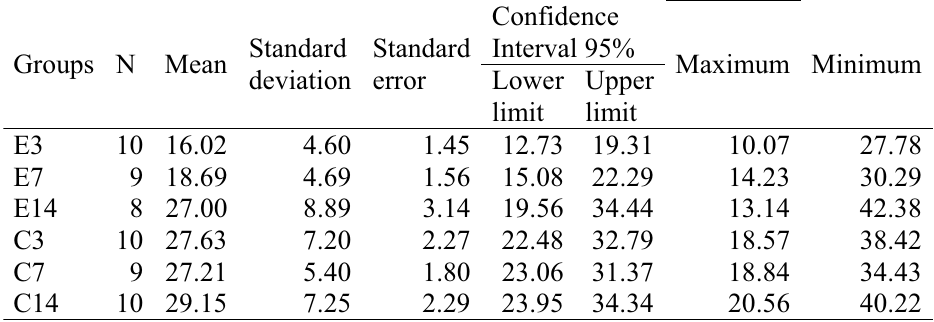
TABLE 1 - Tensile rupture strength of the abdominal wall surgical wound in the experimental group (E) and in the control group (C)